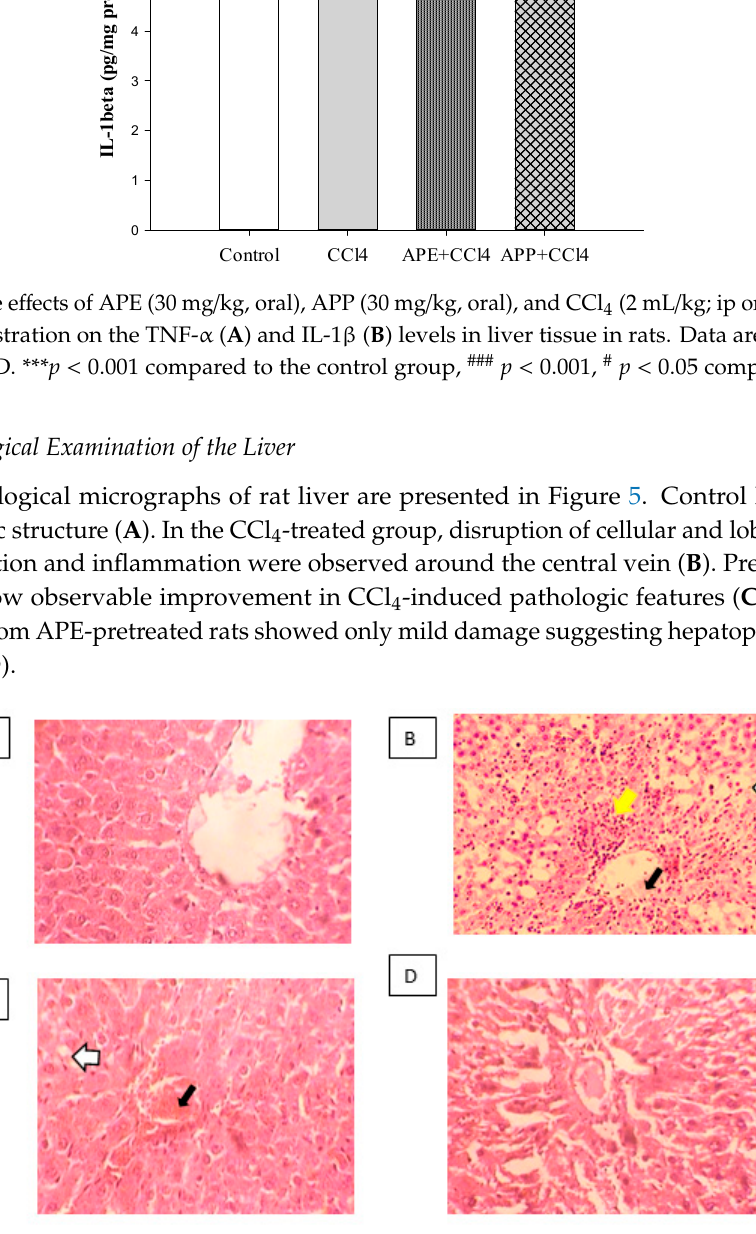
Figure 5. Micrographs of hematoxylin- and eosin-stained liver tissues are presented ( × 10). Control livers present normal histologic structures ( A ). CCl 4 ( B ) and APP + CCl 4 ( C ) treated livers show disrupted cell boundaries and cellular necrosis (white arrows), congestion of the central vein (black arrows) and inflammation (yellow arrow) whereas APE + CCl 4 ( D ) livers show enhanced histopathologic features.